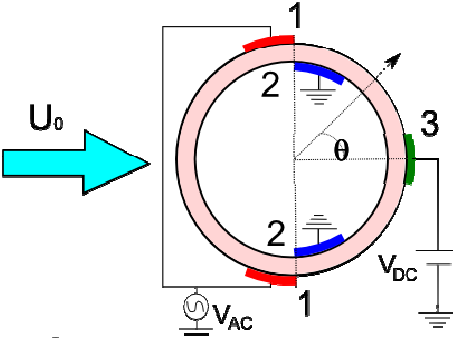
Figure 8. A DBD plasma actuator comprised of the three-electrode configuration. Numbers indicate the Fig. 9 Streamwise component velocity distribution in the wake of different electrodes (from the work by the authors of [103]). The arrow shows the free stream direction. the cylinder obtained from an average of 150 PIV images, at a downstream position of x/D = 3 and a Re D = 4,500 Recently, D’Adamo et al. used a modified three-electrode DBD configuration in which the exposed electrode covers the entire front side of the cylinder (from − 90 ◦ to + 90 ◦ ), the insulated electrode runs over the entire 360 ◦ inside the dielectric, and the third electrode is at the back stagnation point 180 ◦ [104]. With this arrangement and steady mode operation (9 kHz; 11 kV AC), the drag coefficient C D could be reduced from ≈ 1.1 in the uncontrolled flow down to ≈ 0.80 with regular DBD actuation, which could be further reduced to ≈ 0.64 by DC energizing the third electrode (TEBDB) at the highest DC voltage of 11kV ( C µ = 0.15). Remarkably, C D could be further reduced to ≈ 0.56 by operating the actuators in the burst mode and selectively forcing at f e ≈ f vs ,0 ( St f ≈ 0.20). A duty cycle of at least 31% was necessary to attain this amount of reduction. It should be noted that C D was estimated from time-averaged mean velocity profiles in the wake obtained with a PIV